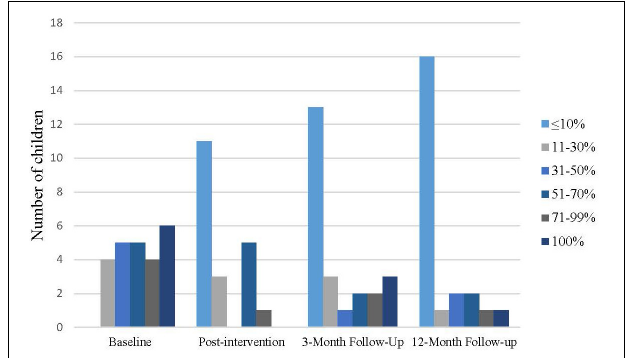
FIGURE 3 | Level of school